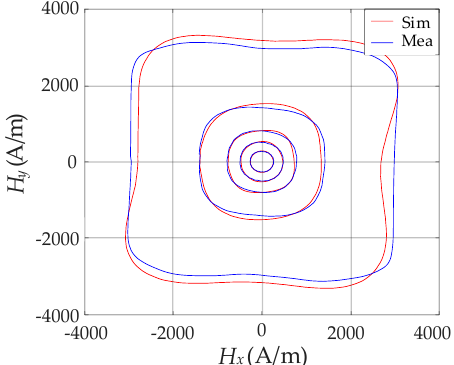
Figure 13. Comparison between experimental H and simulated H based on hybrid algorithm of PSO – Powell.